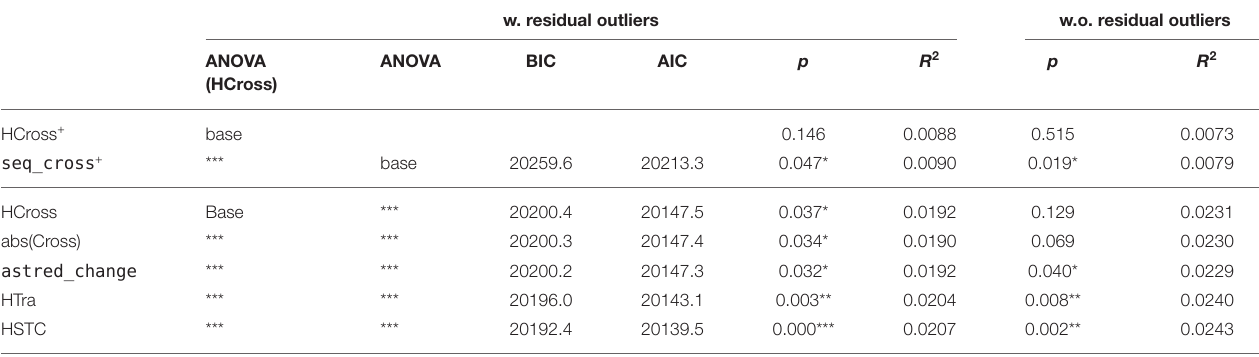
TABLE 2 | Summary of effects on Eye-Key Span (EKS).